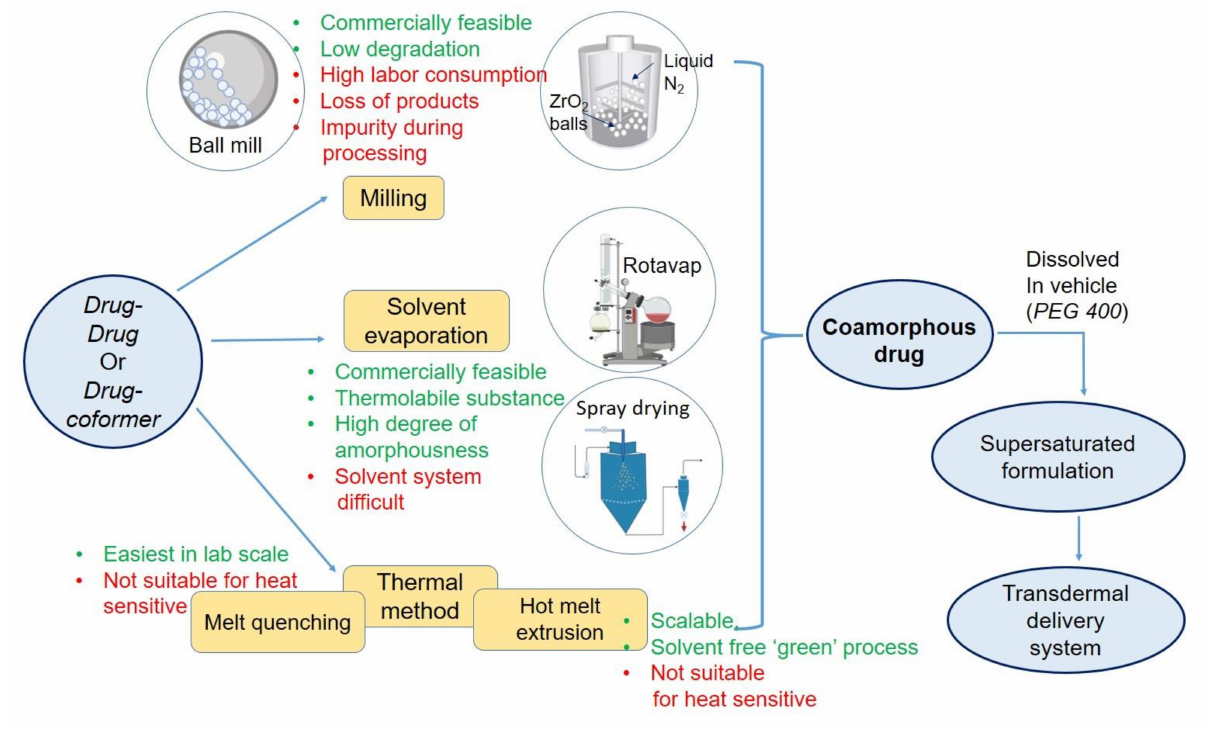
Figure 3. Various method of formulating coamorphous drug loaded transdermal